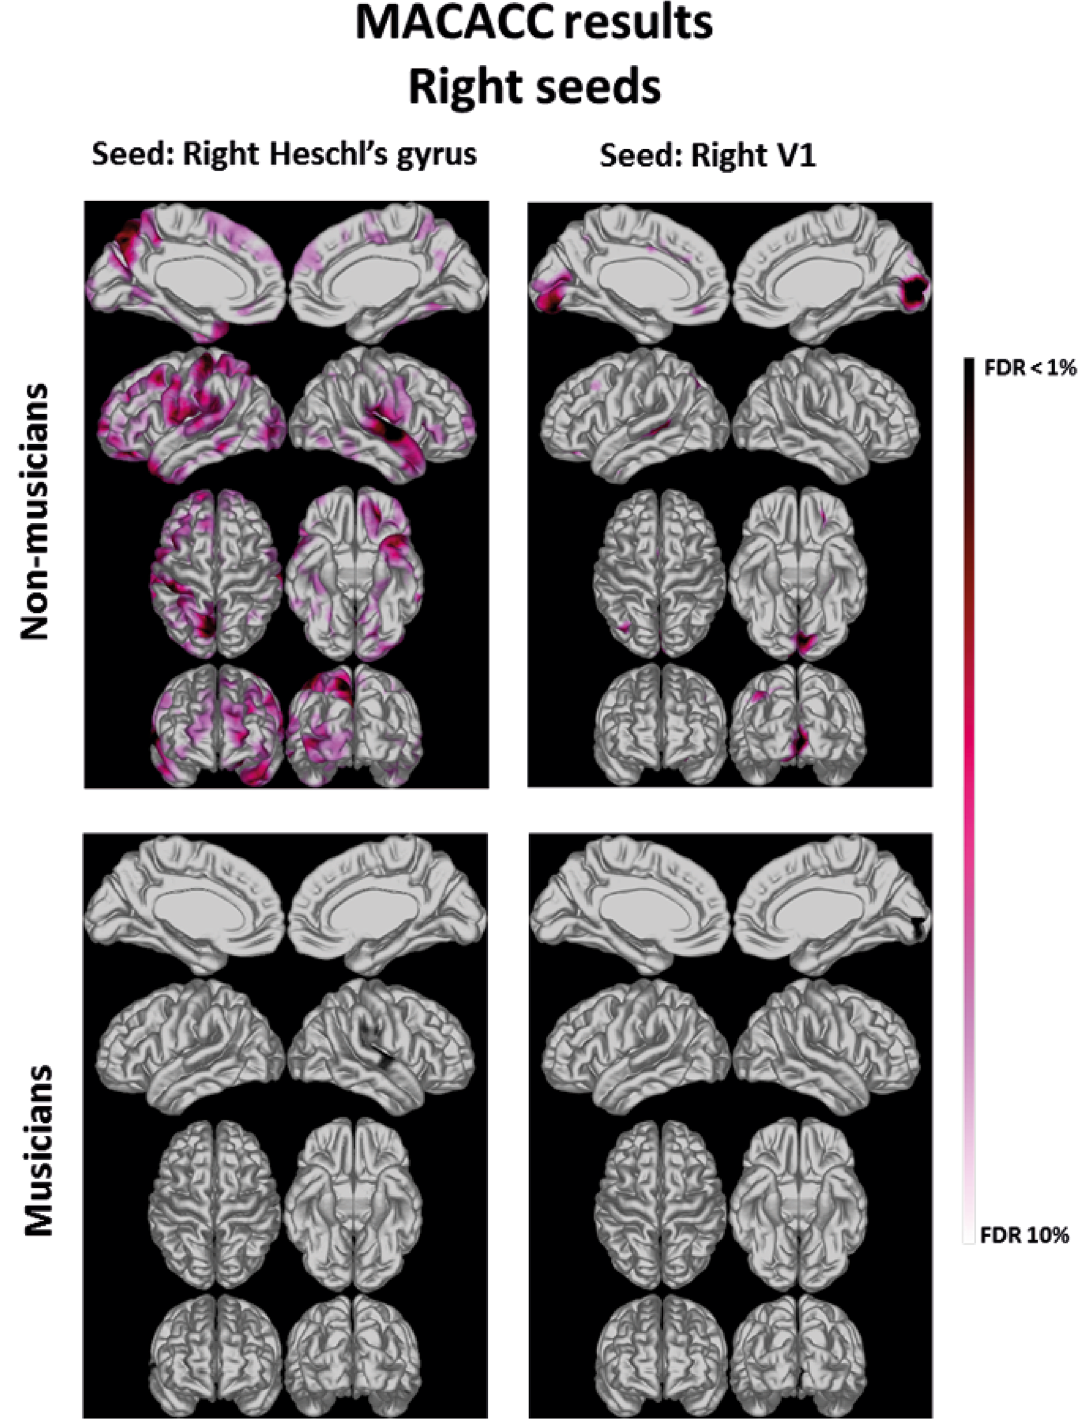
Figure 4. Significant correlations between the cortical thickness (CT) of vertices of the whole brain and vertices of seeds in right Heschl’s Gyrus (left column) and right V1 (right column). FDR = False discovery